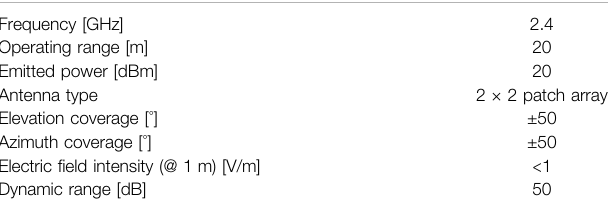
TABLE 1 | Radar system parameters.